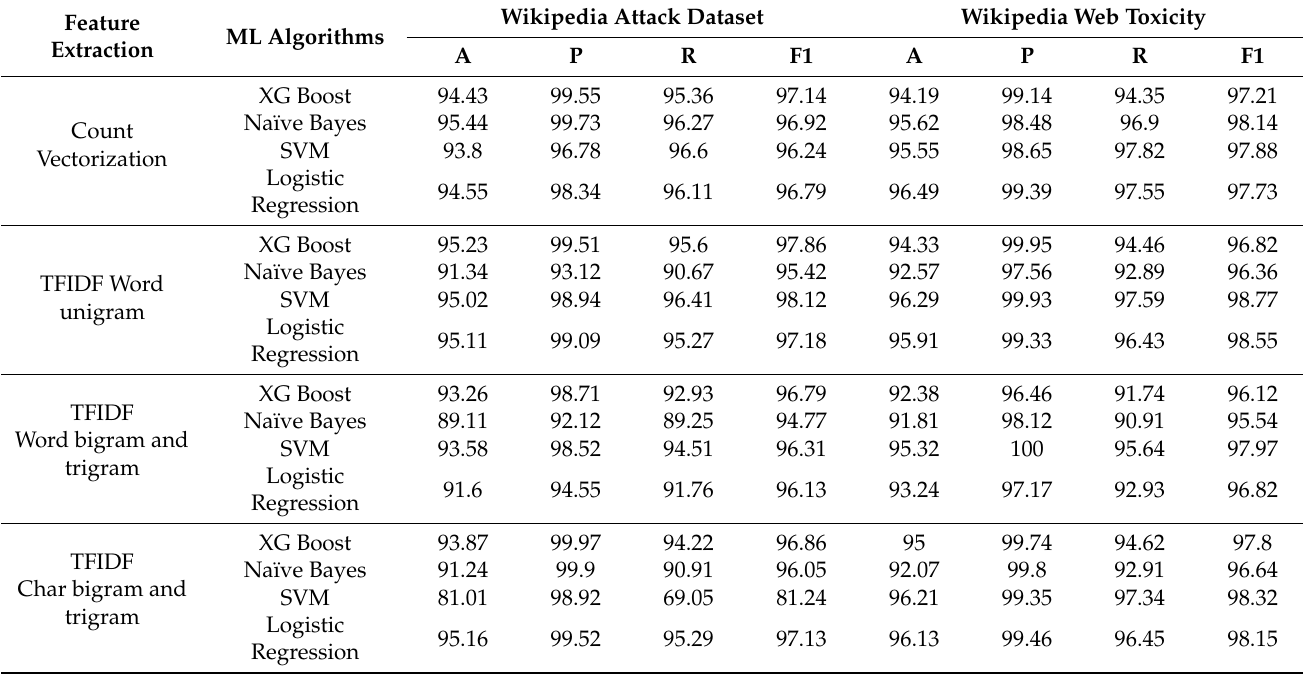
Table 1. Results of four traditional machine learning models with four feature extraction techniques on two datasets. Feature